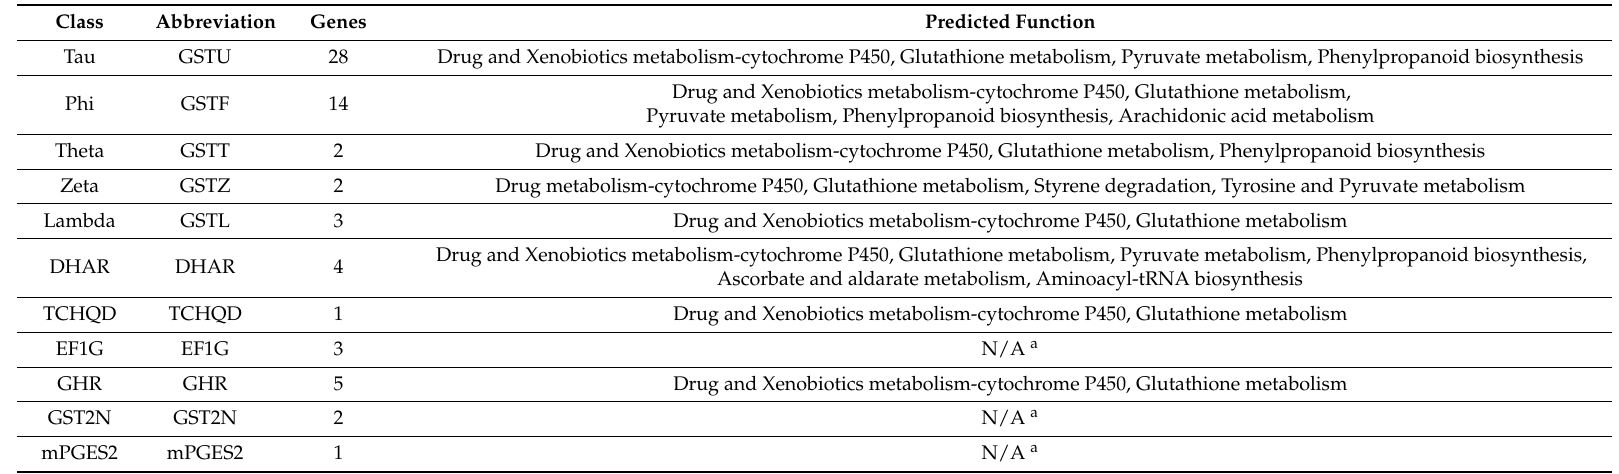
Table 3. Organization of GST super-family in B. oleracea based on pathway analysis using KEGG